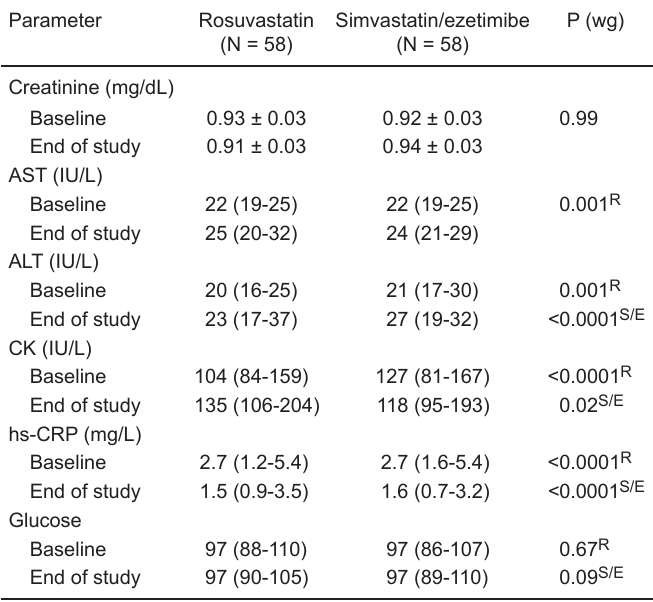
Table 3. Laboratory parameters by groups at baseline and at the end of the